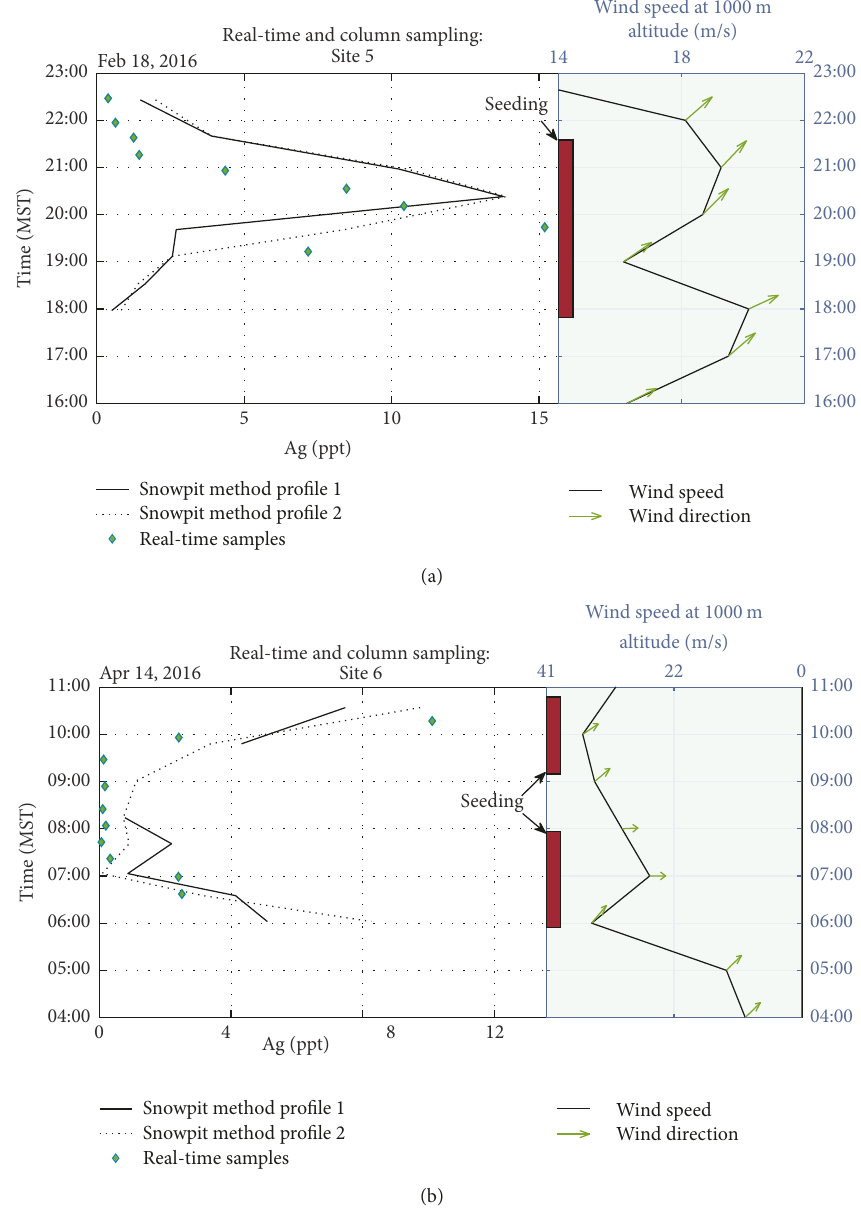
Figure 5: Validation of time-delineation methods. We compare real-time samples (green diamonds) with time-delineated column samples (each black line is a profile of column samples). Wind speed and direction are plotted to the right with red bars delineating times of active seeding. Of the 17 ground generators, 16 and 17 were active for sites 5 and 6,